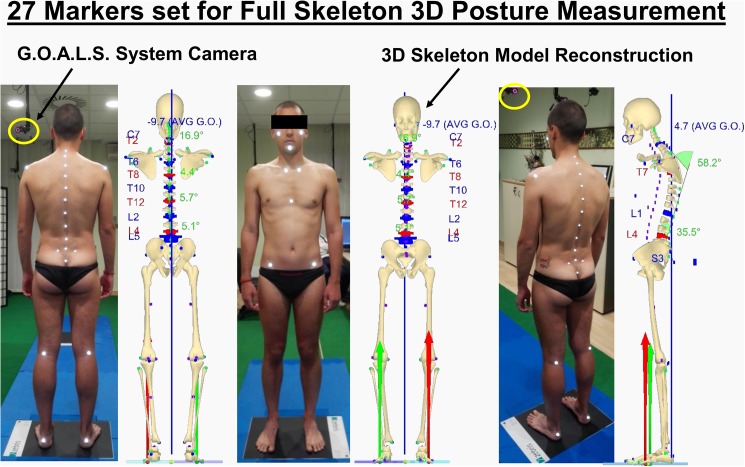
An example of full 3D skeleton reconstruction.